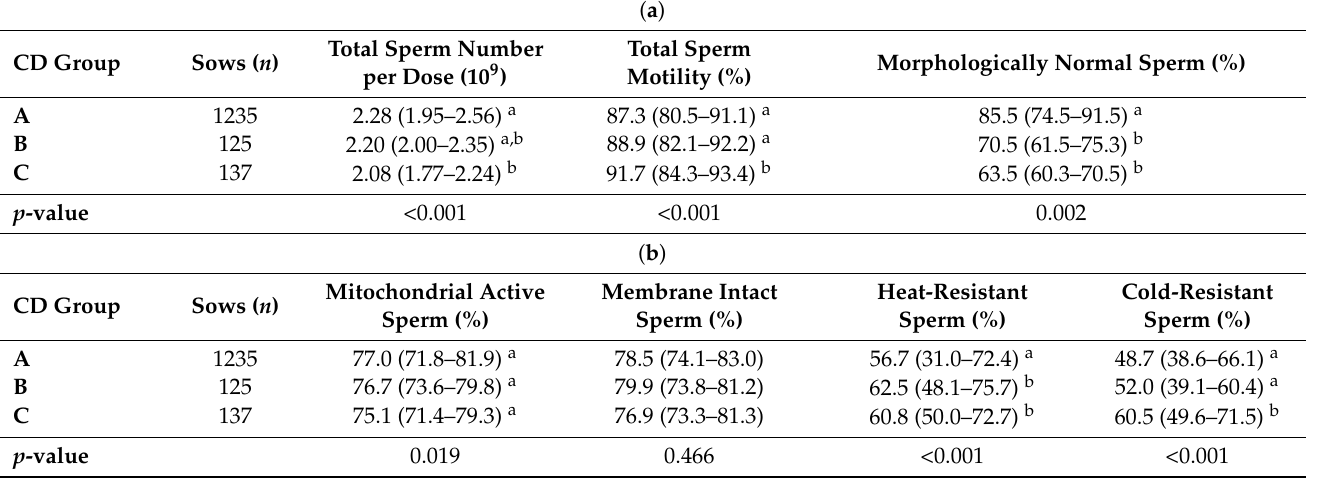
Table 4. Standard sperm traits ( a ) and functional sperm traits ( b ) regarding three different levels of cytoplasmic droplet (CD) rates in the semen used for insemination: A: low (<10%), B: moderate ( ≥ 10% and <15%) and C: high ( ≥ 15%). Values are shown as median (interquartile range). Significant differences between the groups are marked by different superscript index letters (a, b).